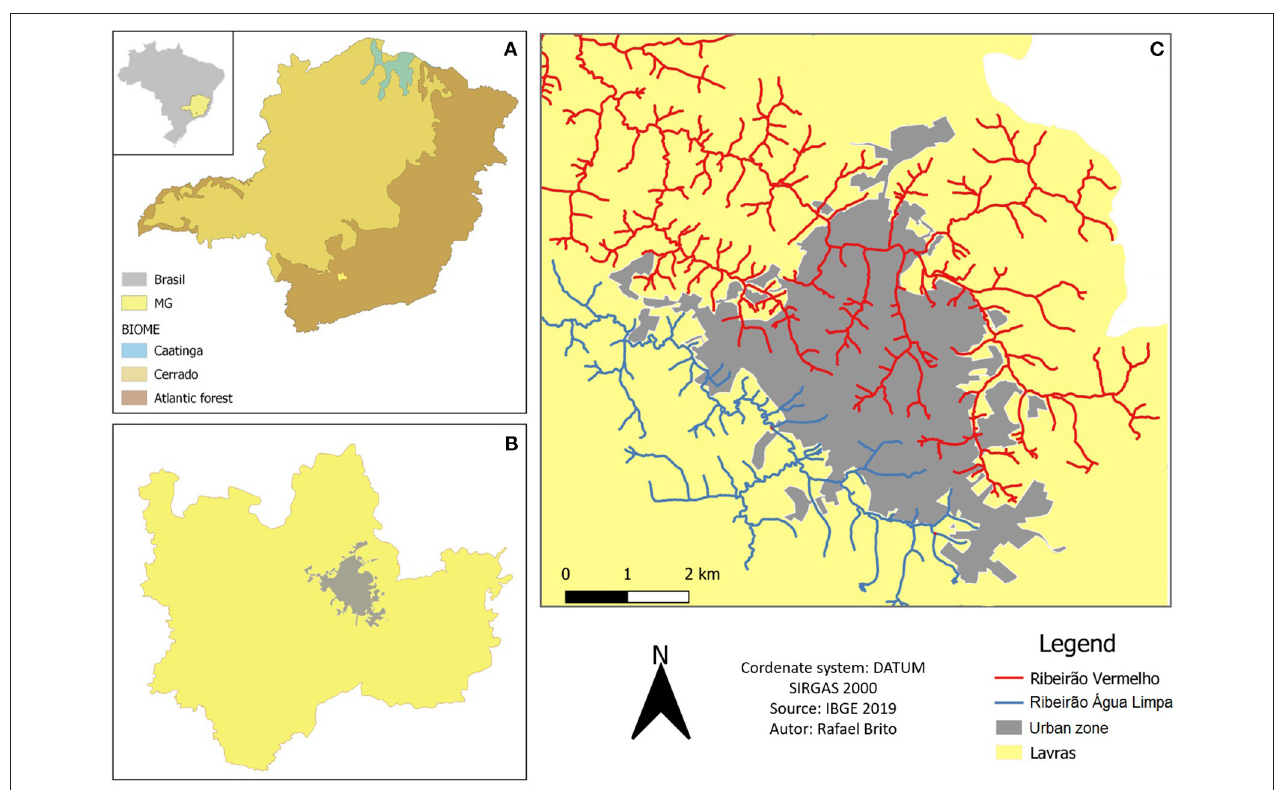
FIGURE 1 | The State of Minas Gerais, Brazil (A) . The municipality of Lavras (B) Geographic location of the urban area of Lavras and its main basins (C) .